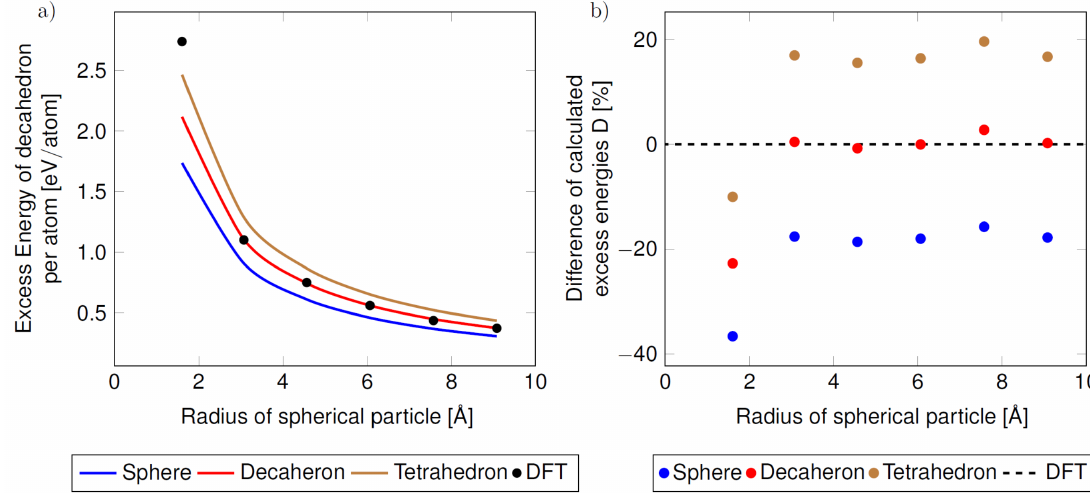
Figure 6. The computed excess energies of the studied nanoclusters/nanoparticles (per atom and as functions of the nanoparticle radius) as obtained from the phenomenological thermodynamic modeling when considering different shapes of the nanoparticles with the same number of atoms. The absolute excess energies are shown in part ( a ) and compared with the excess energies from the direct DFT calculations of the actual decahedral nanoparticles (shown as black symbols in part ( a )). The differences of the excess energies are presented also relatively in part ( b ) with respect to the DFT values (horizontal black dashed line). The blue curve in part ( a ) and blue data points in part ( b ) correspond to the spherical shape, red to the decahedral shape and brown to the tetrahedral